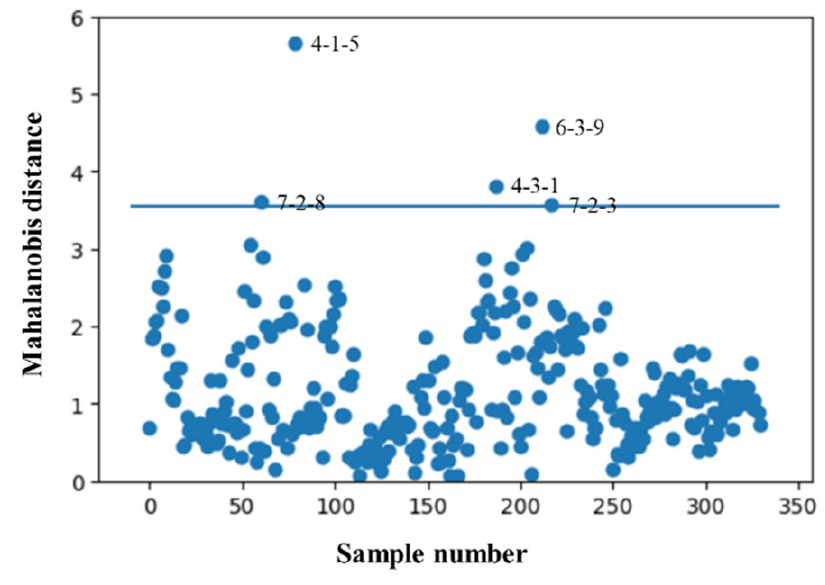
Figure 4. Mahalanobis distance distribution diagram of the samples.